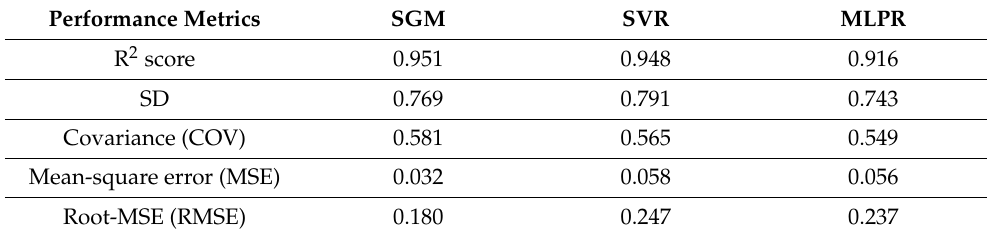
Table 4. Model performance.